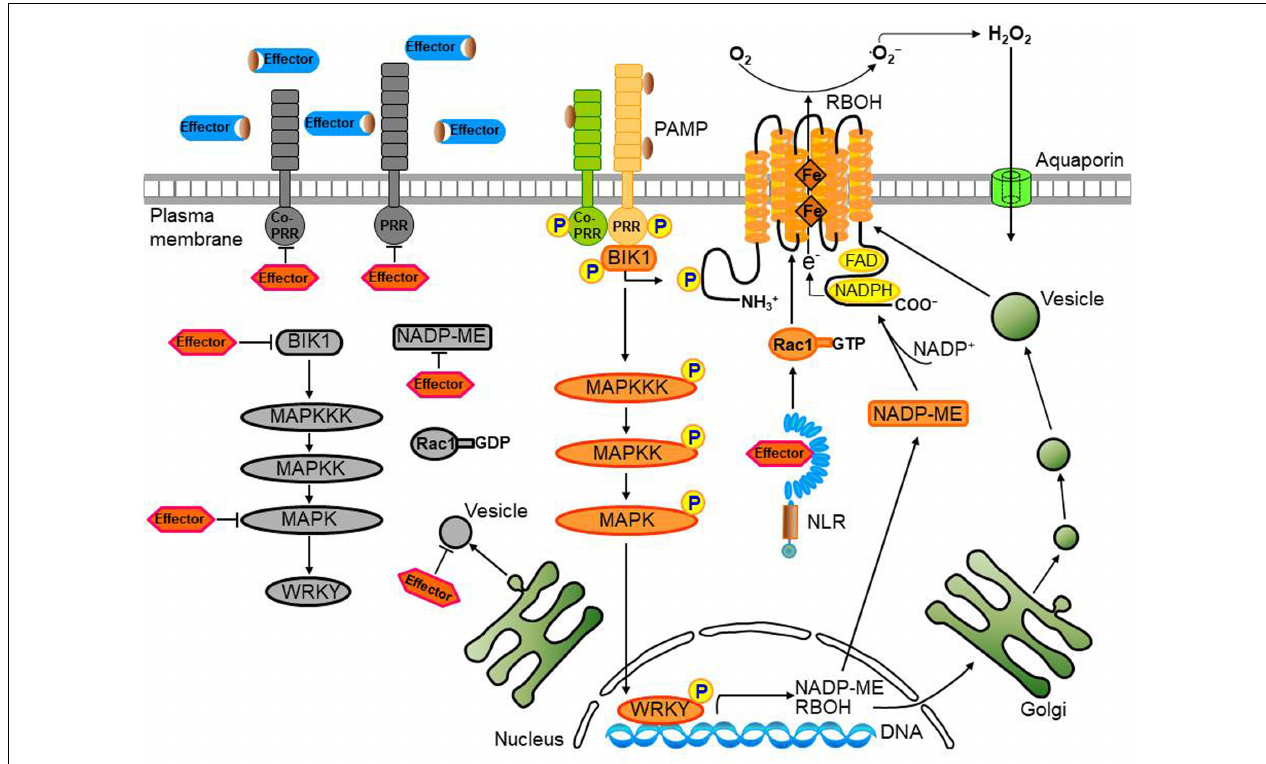
FIGURE 3 | Convergent effector targeting of ROS signaling networks in plant cells. Plant pathogens secrete effectors into the apoplastic area and cytoplasm of plant cells. These apoplastic effectors interfere with PRR-mediated PAMP recognition, ultimately leading to the inactivation of plasma membrane-bound RBOHs. Cytoplasmic effectors target the kinase domains of PRRs, the receptor-like cytoplasmic kinase (RLCK) BIK1, MAPK cascades, and WRKY transcription factors, inhibiting the transcription of RBOHs and NADP-ME , both essential for robust ROS generation. A bacterial type III effector inhibits BIK1 downstream of the PRR (BAK1), enhancing virulence. Some cytoplasmic effectors target vesicle trafficking, suppressing the transport of ROS-producing RBOH enzymes to the plasma membrane during infection. Secreted pathogen effectors block the metabolic coenzyme NADP-ME, inhibiting the transfer of electrons to the NADPH oxidases (RBOHs) responsible for ROS generation. The biomembrane channels, aquaporins, mediate H 2 O 2 transport across biological membranes. However, when specific pathogen effectors recognize intracellular NLR proteins, the effector no longer functions as a virulence factor; here, the effector-NLR complex leads to a strong apoplastic ROS burst and HR cell death response. The PRR-associated kinase BIK1 directly phosphorylates the NADPH oxidase RBOHD to enhance RBOHD-mediated ROS production. Rac1 directly interacts with both NLR and RBOH to activate RBOH. Apoplastic ROS are toxic to pathogens and also activate MAPK cascades and RBOH enzymes in their role as immune signal